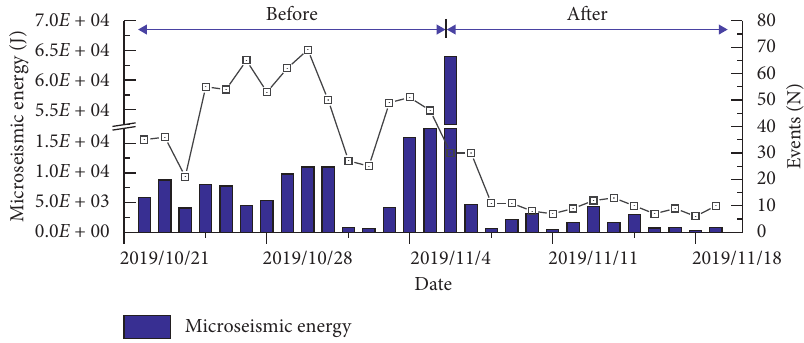
Figure 13: Microseismic energy and events distribution of roof